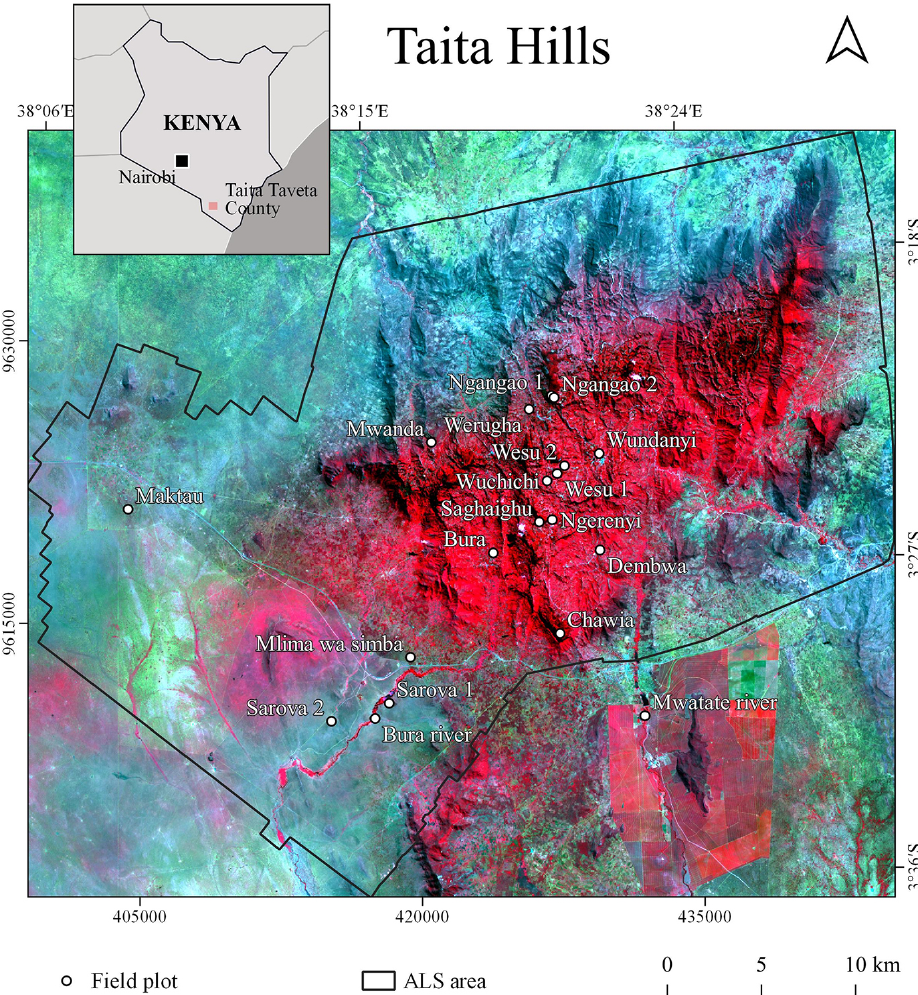
Figure 1. Field plots with microclimate sensors in Taita Taveta County, Kenya. ALS refers to airborne laser scanning. The base map is a false color Landsat 8 OLI image from 4 July